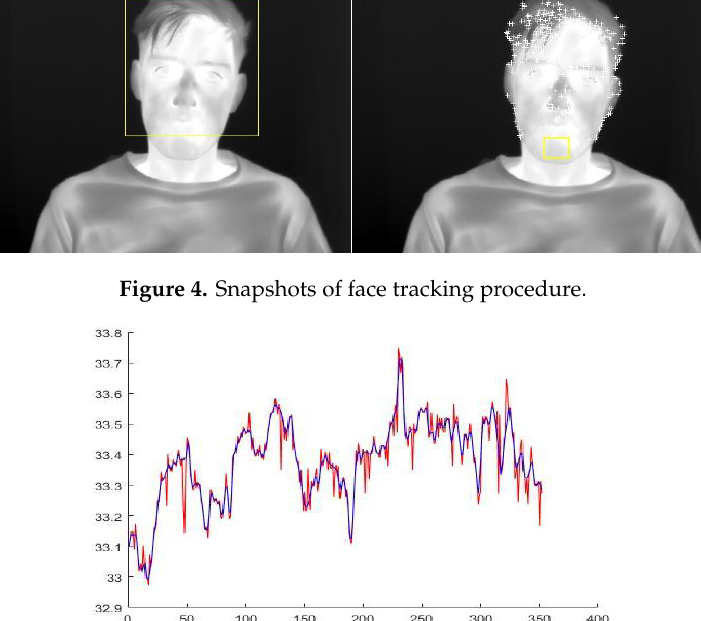
Figure 5. Raw thermal signal ( red line )-smoothed thermal signal using rlowess method ( blue line ).